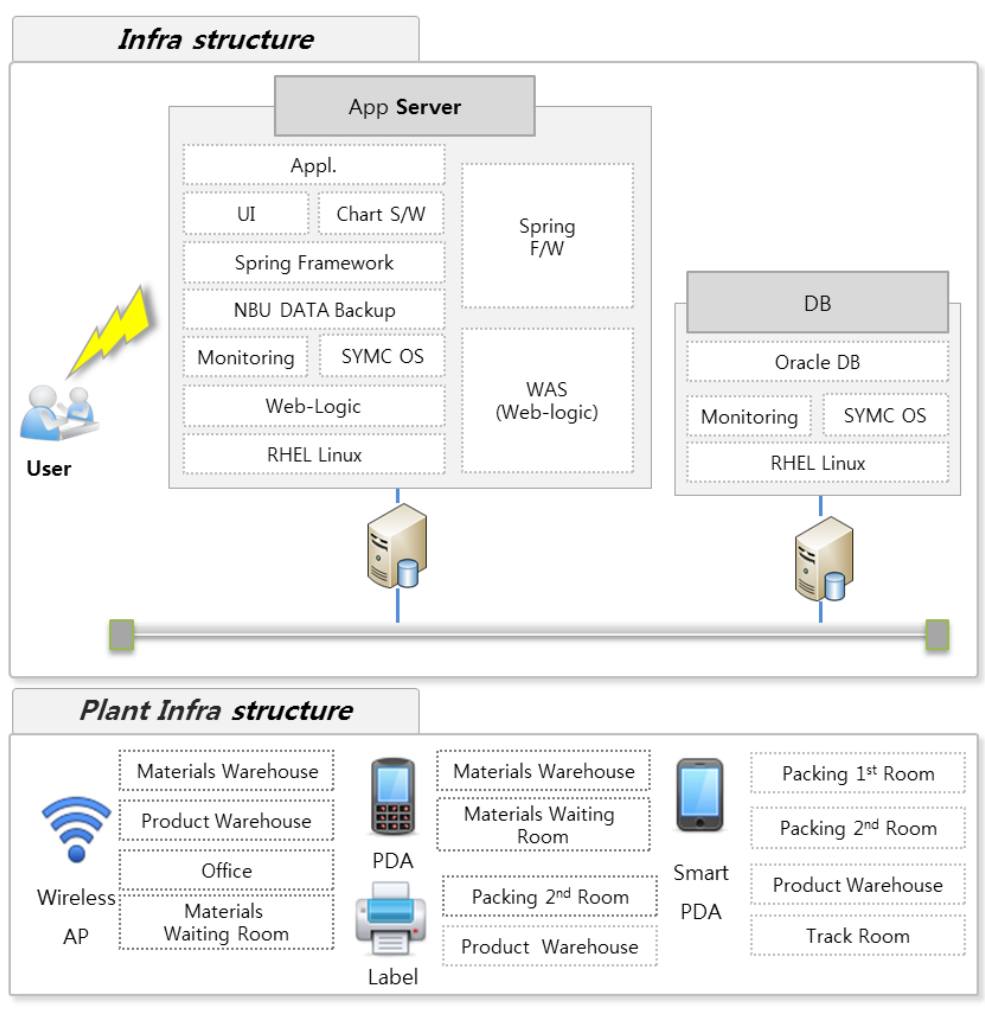
Figure 19. Infra Structure of Factory.